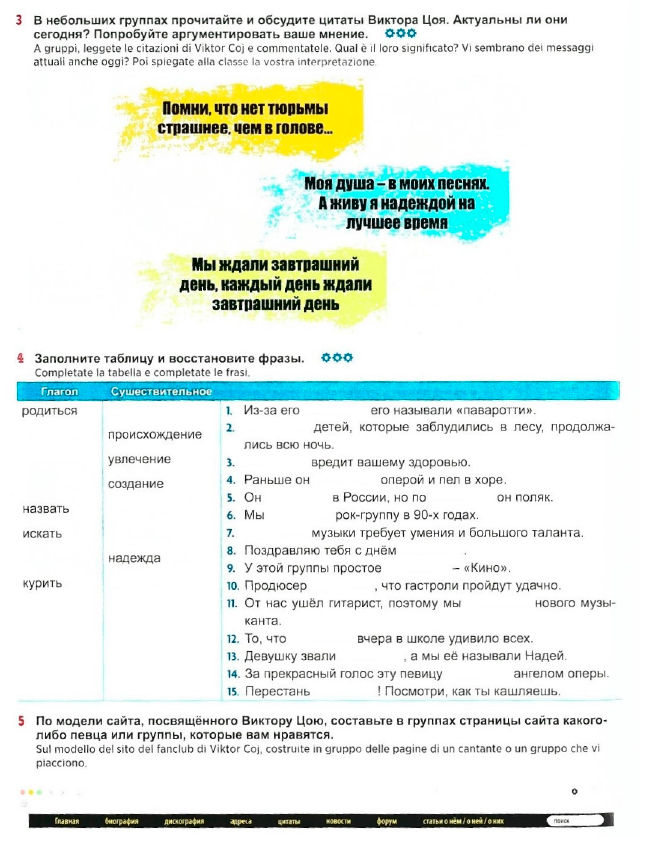
Figure 8. Example 2 of a task in Davayte .